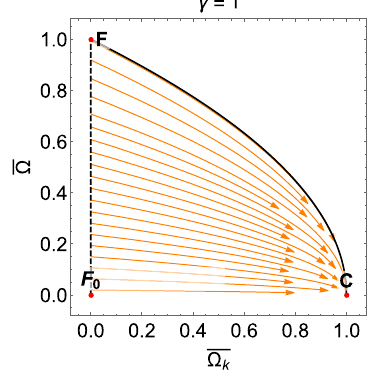
Fig. 6 Phase plane of system (109) for γ = 1